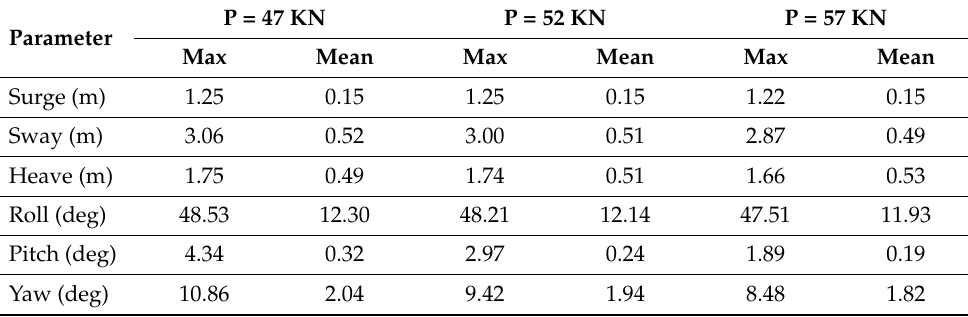
Table 7. Comparison of 6 DOF motions of foundations with different pretension loads.